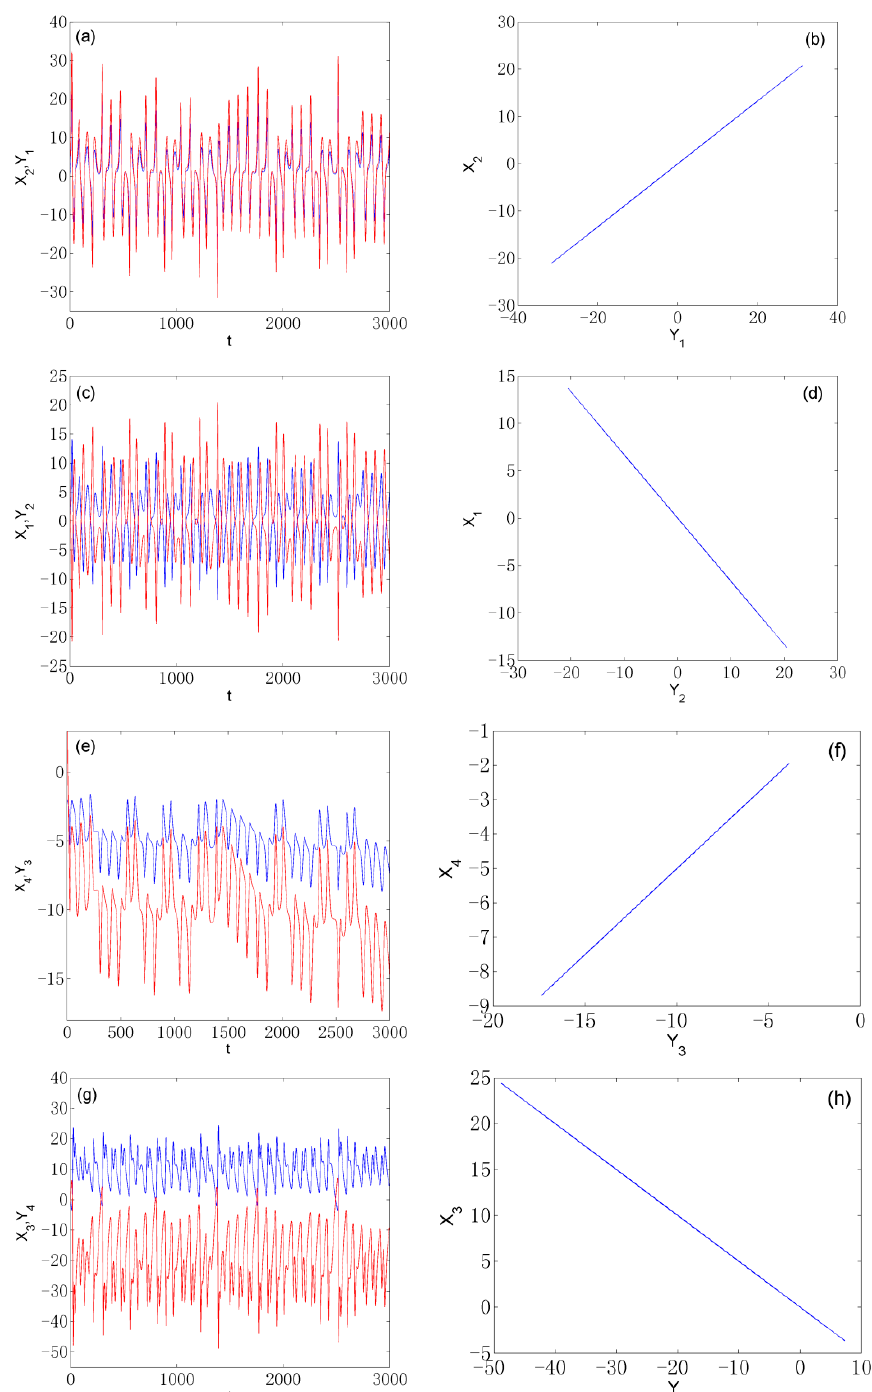
Figure 5. Time series diagram and synchronization plots of generalized dislocation synchronization. ( a , c , e , g ) Time series diagrams. ( b , d , f , h ) The synchronization plots. In ( a ), the blue line is X 2 and the red line is Y 1 . In ( c ), the blue line and the red line means X 1 and Y 2 , respectively. In ( e ), the blue line and the red line means X 4 and Y 3 , respectively. In ( g ), the blue line and the red line means X 3 and Y 4, respectively.